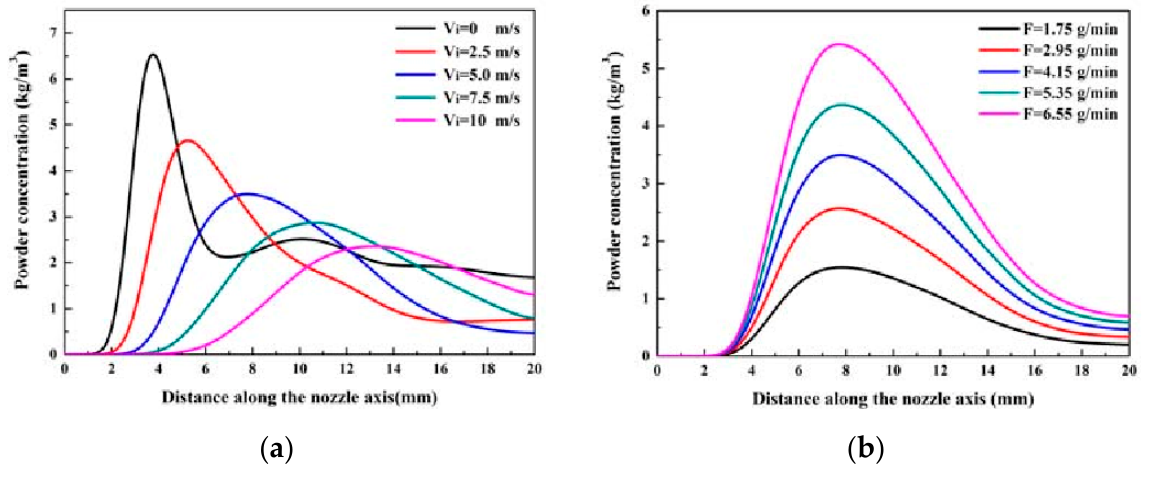
Figure 11. Variation of particle concentration with ( a ) inner shielding gas velocity and ( b ) powder flow rate [71].